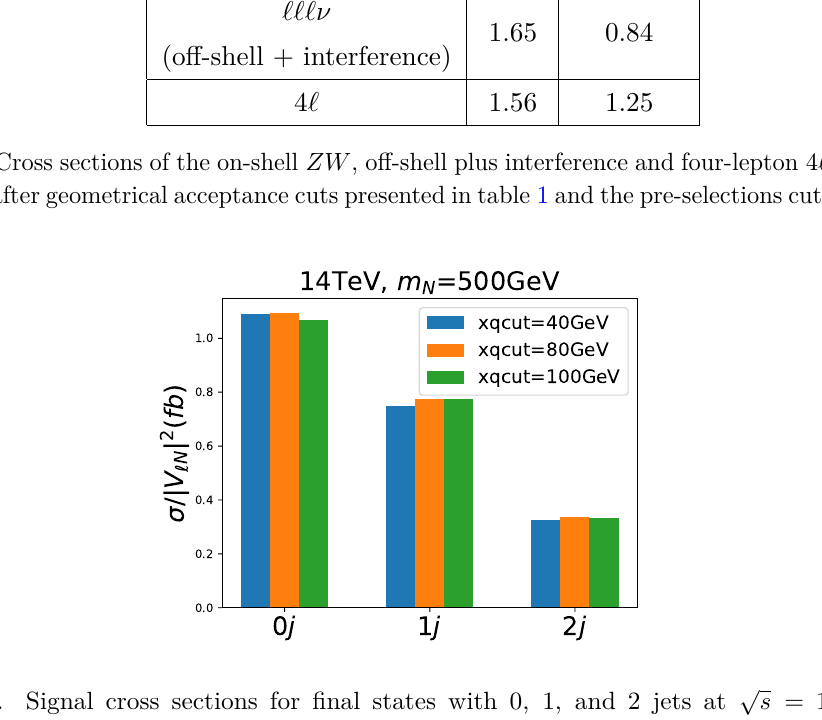
Figure 3 . Signal cross sections for final states with 0, 1, and 2 jets at m N = 500 GeV. The parameter xqcut is taken to be 40 GeV, 80 GeV and 100 GeV for